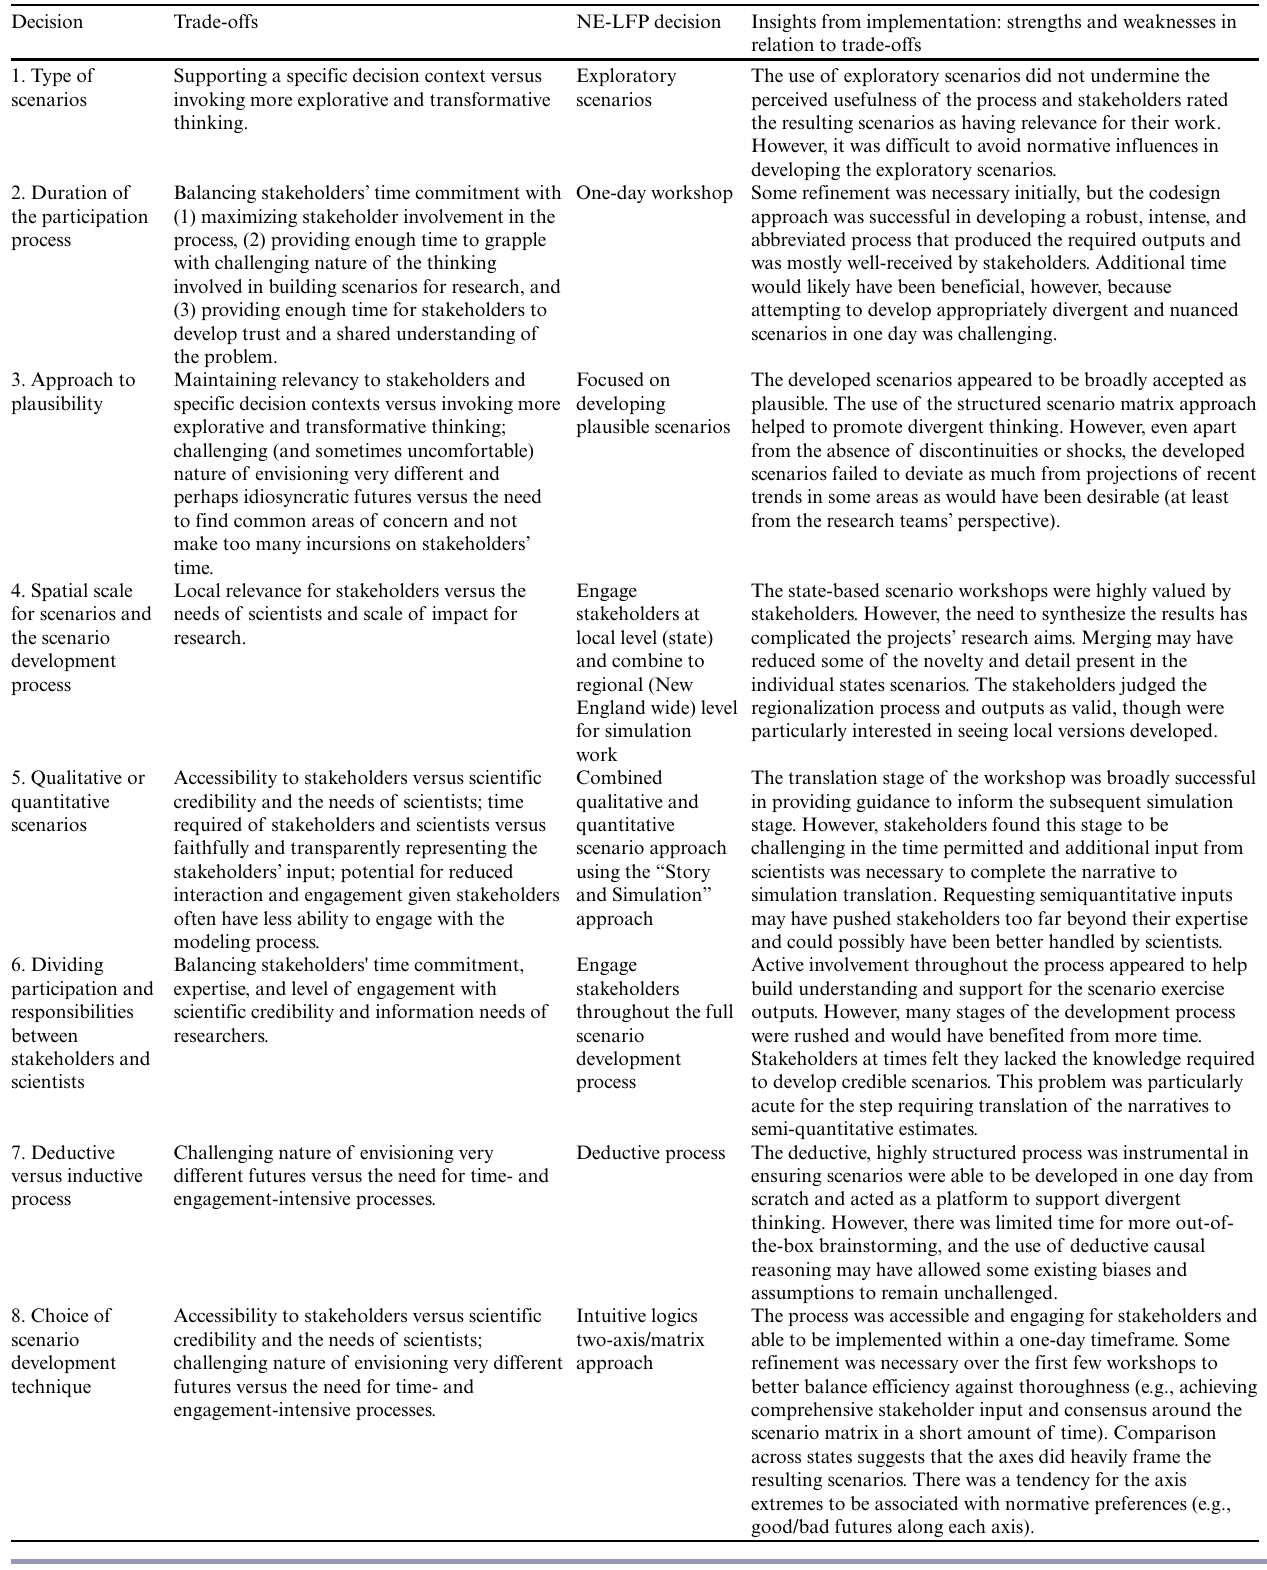
Table 3 . Decisions and trade-offs made during the New England Landscape Future Project (NE-LFP) scenario development